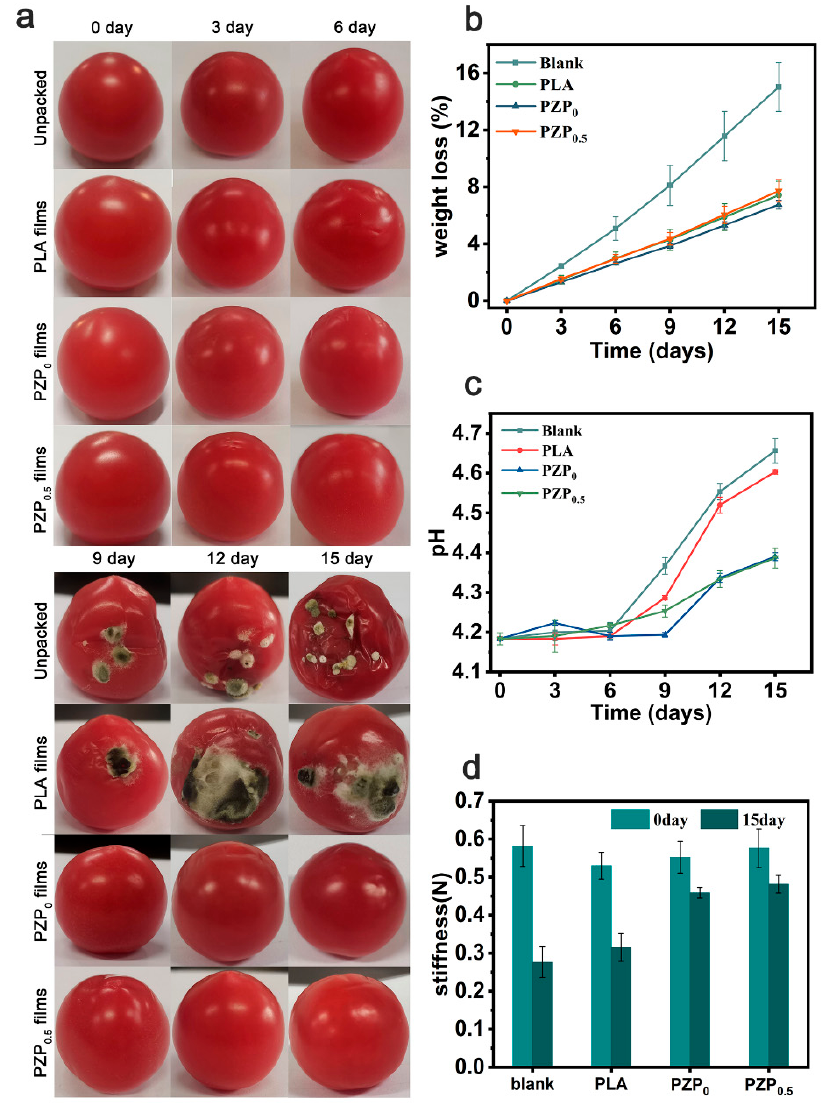
Figure 7. ( a ) Typical pictures of cherry tomatoes at different times with various treatments (unpacked, packed, PLA, PZP 0 and PZP 0.5 film), ( b ) weight loss, ( c ) pH changes, ( d ) stiffness changes (0 and 15 days).